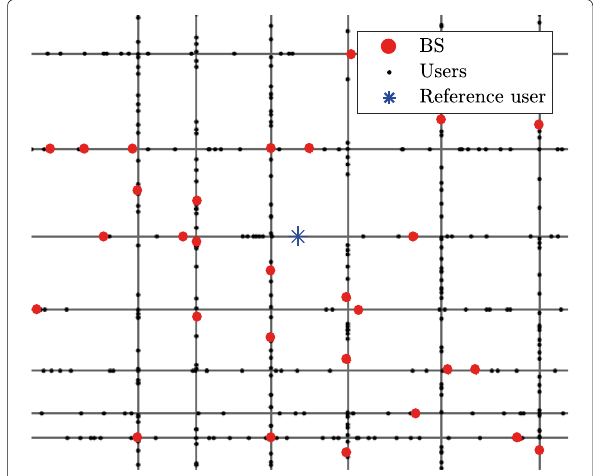
Fig. 9 Manhattan Poisson line process scenario. Example for a realization of streets, BSs, and